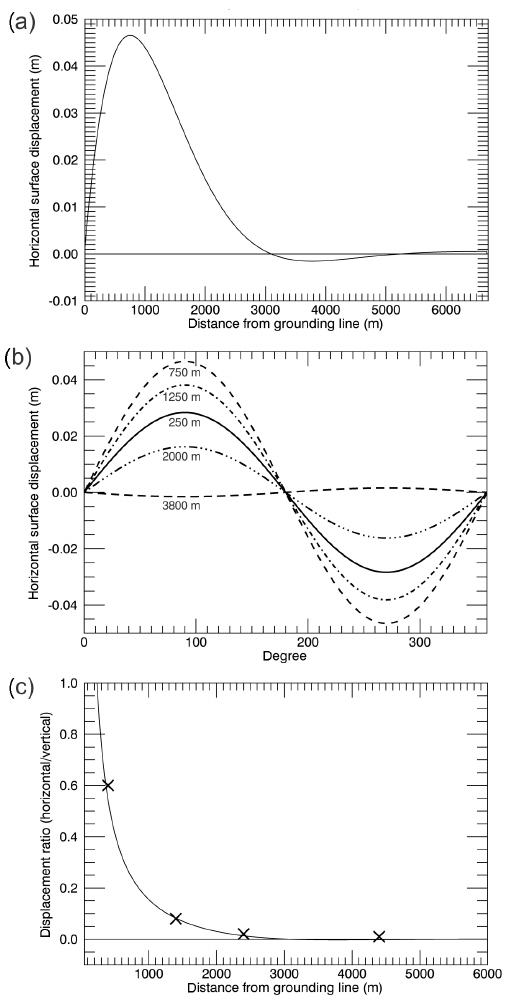
Figure 4. Elastic model calculations for an ice shelf with 250m thickness and E = 1.5GPa for horizontal surface displacement in- tegrated from surface strain perpendicular to the grounding line (a) for a typical high tide in our study area (0.55m) and (b) over a tidal cycle at five different distances from the grounding line. The mean ratio between the horizontal and vertical displacement is shown in (c) together with the values measured at the four GPS stations ( x symbols).